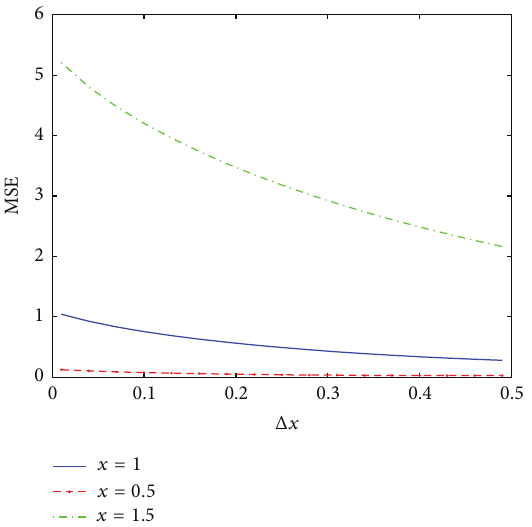
Figure 1: MSE of (7) at 𝑥 = 0.5 , 𝑥 = 1 , and 𝑥 = 1.5 .